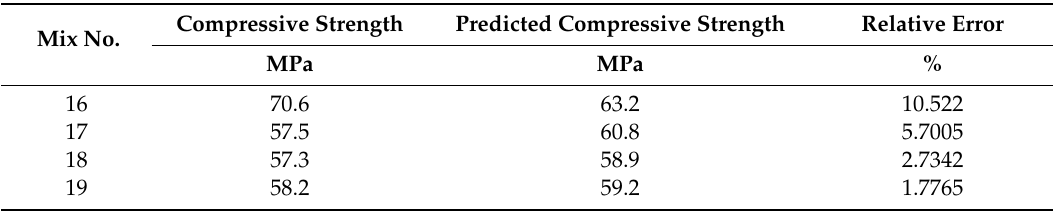
Table 13. The results of the BP neural network generalization ability